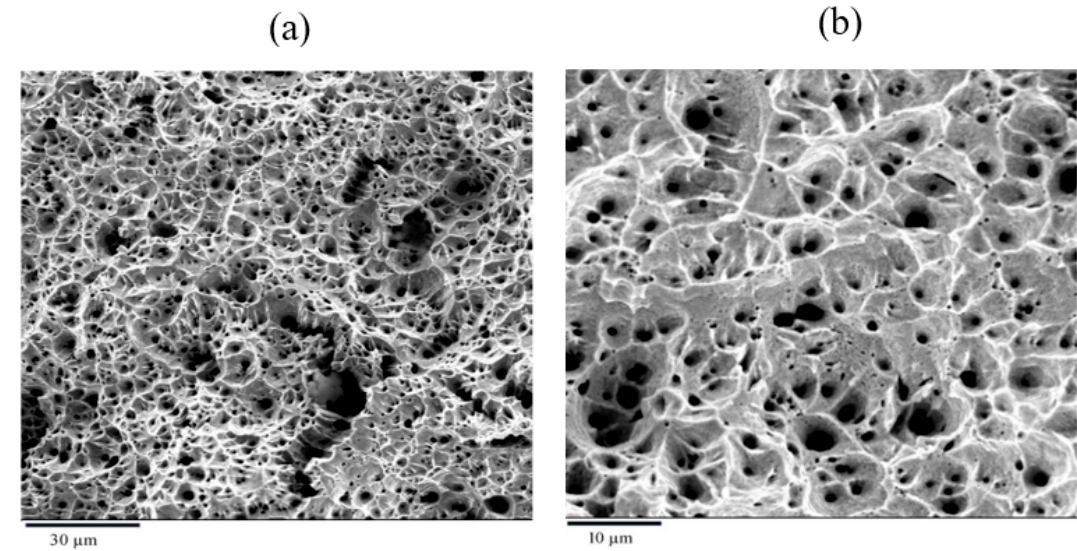
Figure 5. SEM fractography of 316 stainless steel samples tested in ( a ) NC and ( b ) SWSSNC at 60 °C.